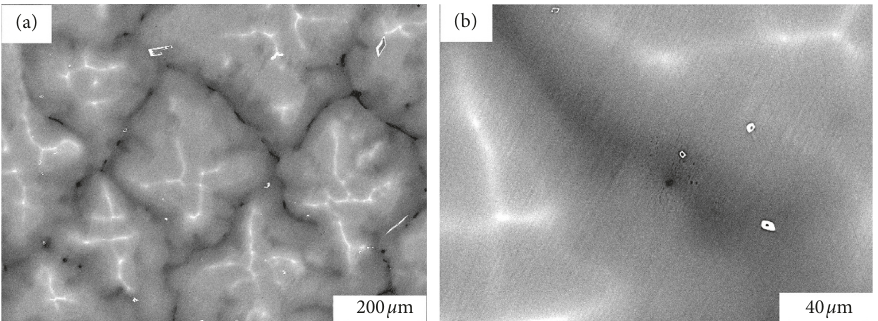
Figure 4: Microstructure of the transverse section of the columnar zone for the 30 μ m/s withdrawn DS ingot: (a) low-magnification BSE image; (b) high-magnification BSE